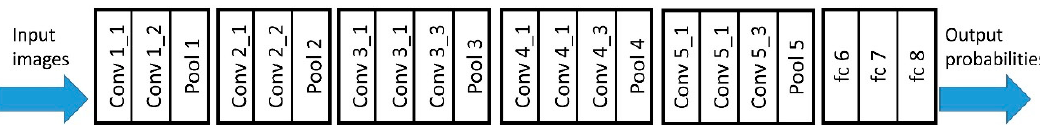
Figure 10. Architecture of VGG-16 net showing 13 convolutional layers (Conv #), 5 pooling layers (Pool #), and 3 fully connected (fc#) layers.